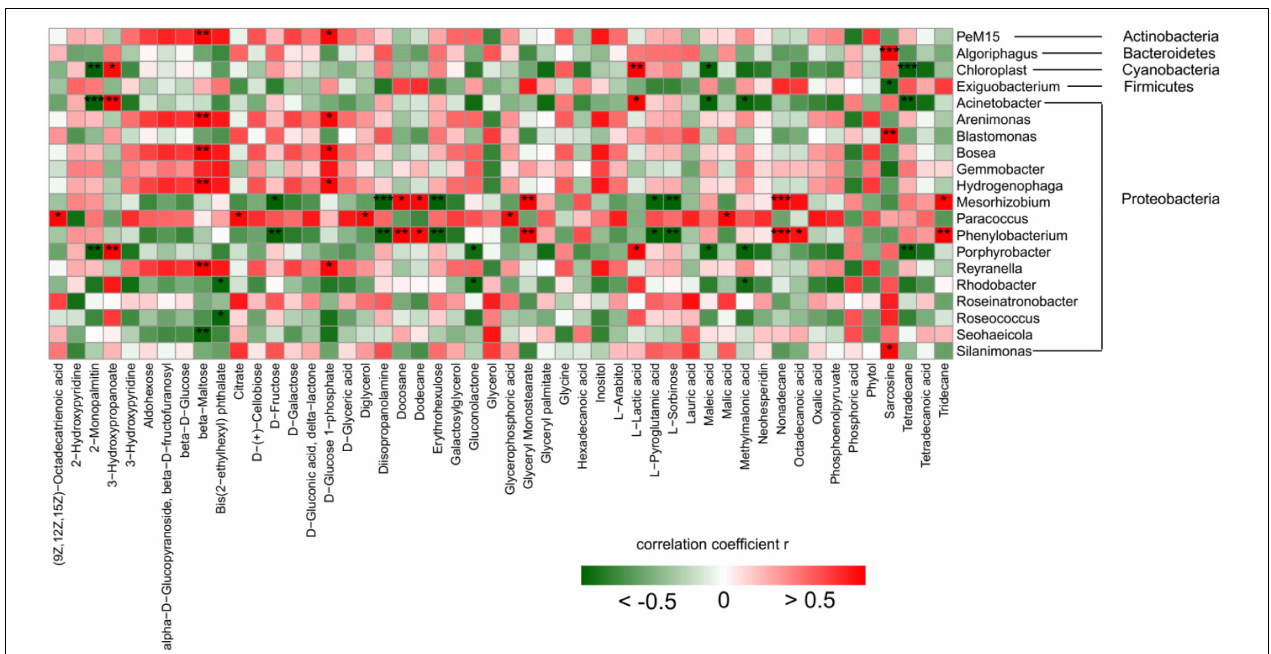
FIGURE 7 | Thermograms of correlation between bacteria and metabolites. The notes on the right are the top 20 bacteria genus; Below are the names of the top 50 metabolites in abundance. Correlation analysis: Pearson correlation coefficient and P value were calculated, and the number of * was marked according to the P value ( P < 0.001, *** means extremely significant correlation; P < 0.01, ** means very significant correlation; P < 0.05, * means significant correlation; P > 0.05, no * means insignificant correlation; Red represents positive correlation, green represents negative